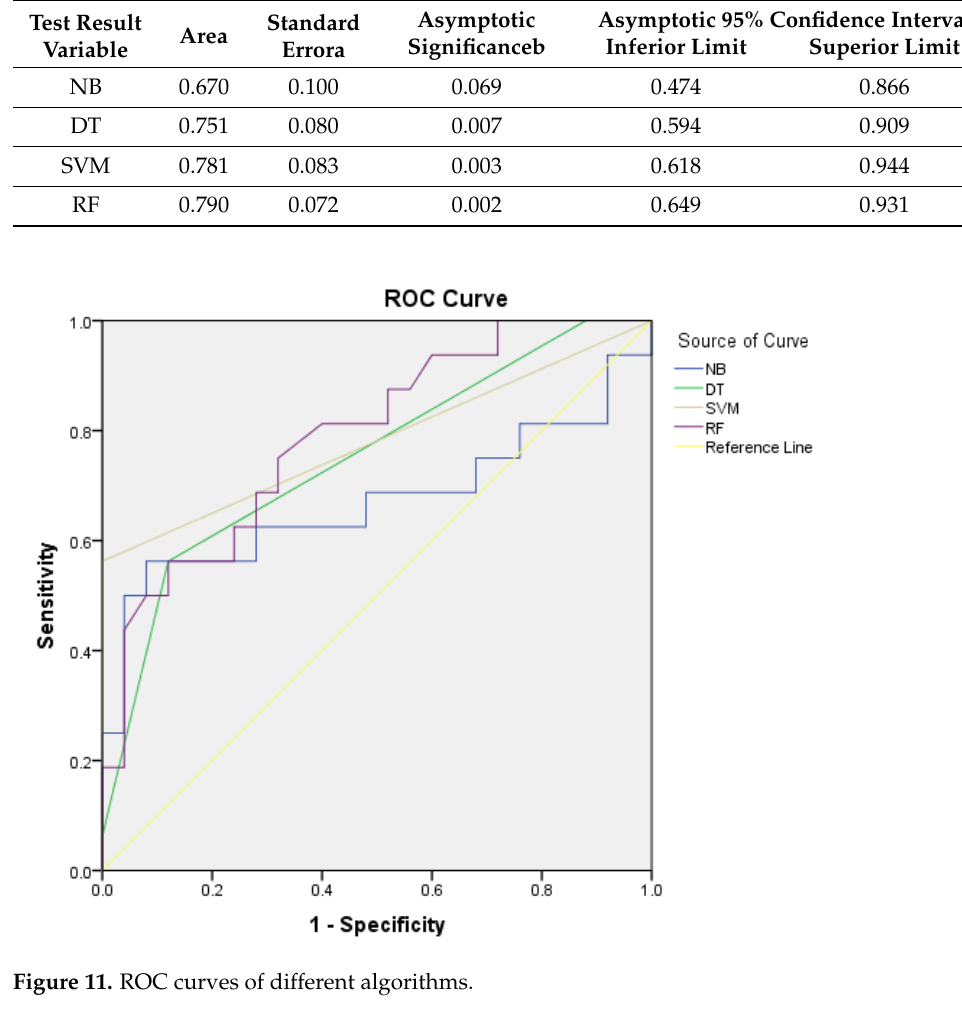
Figure 11. ROC curves of different